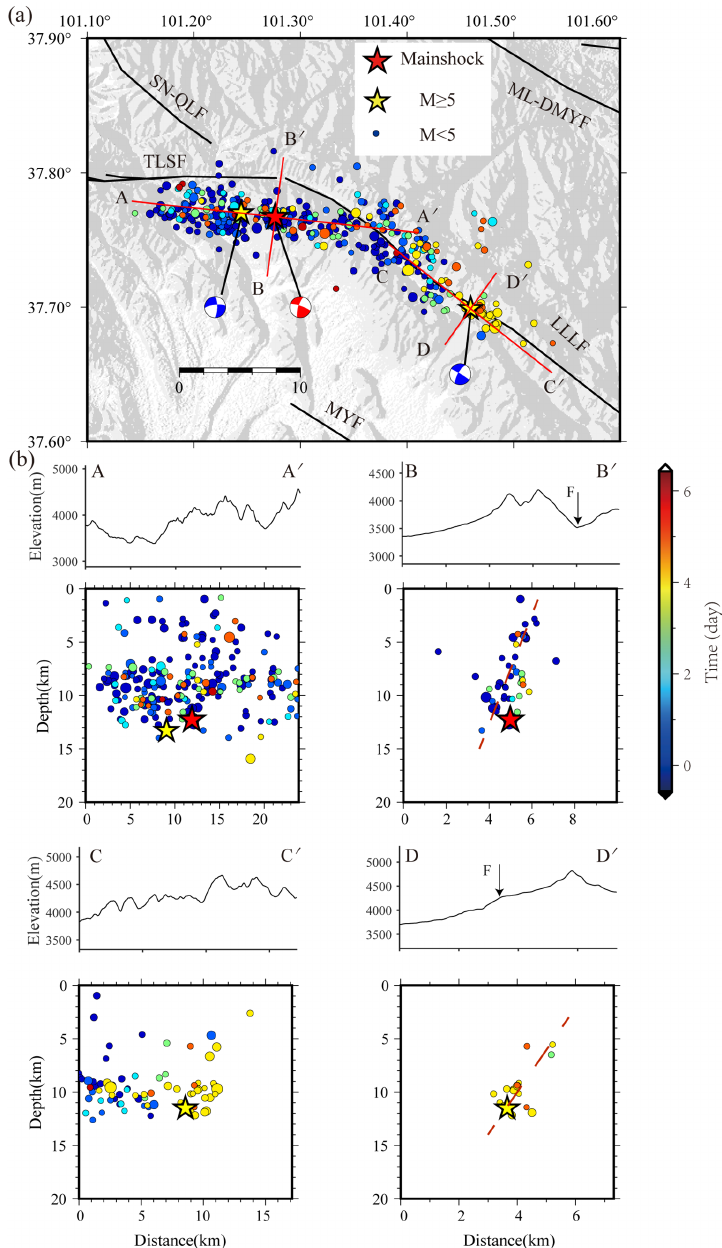
Figure 4. Map view ( a ) and depth distribution ( b ) of the aftershocks along four selected profiles. Earthquakes within 1.5 km of the selected profile lines are included.